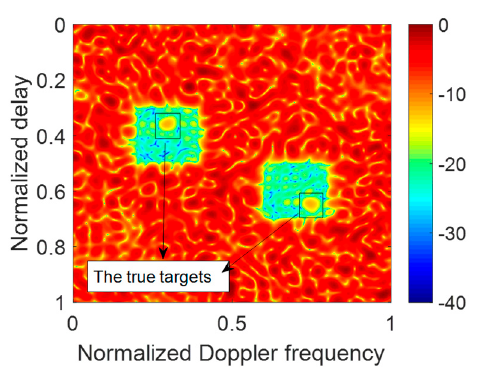
Figure 12. The result of suppressing the JRVDJ using POADMM.